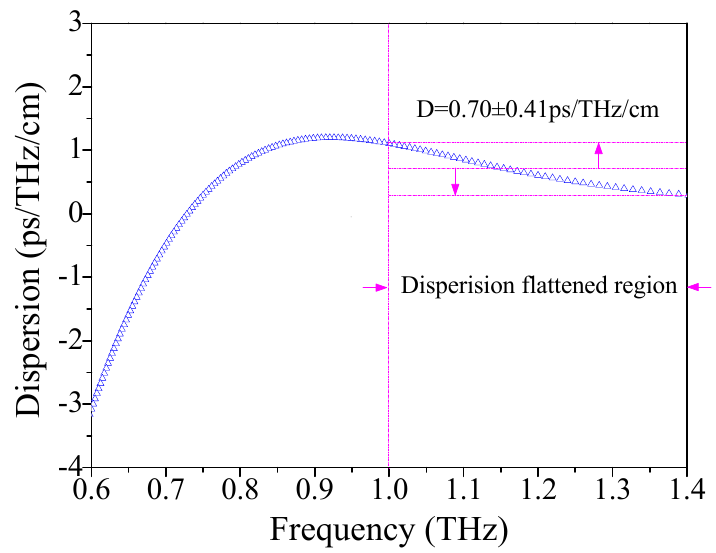
Figure 8. The relation of dispersion with frequency.